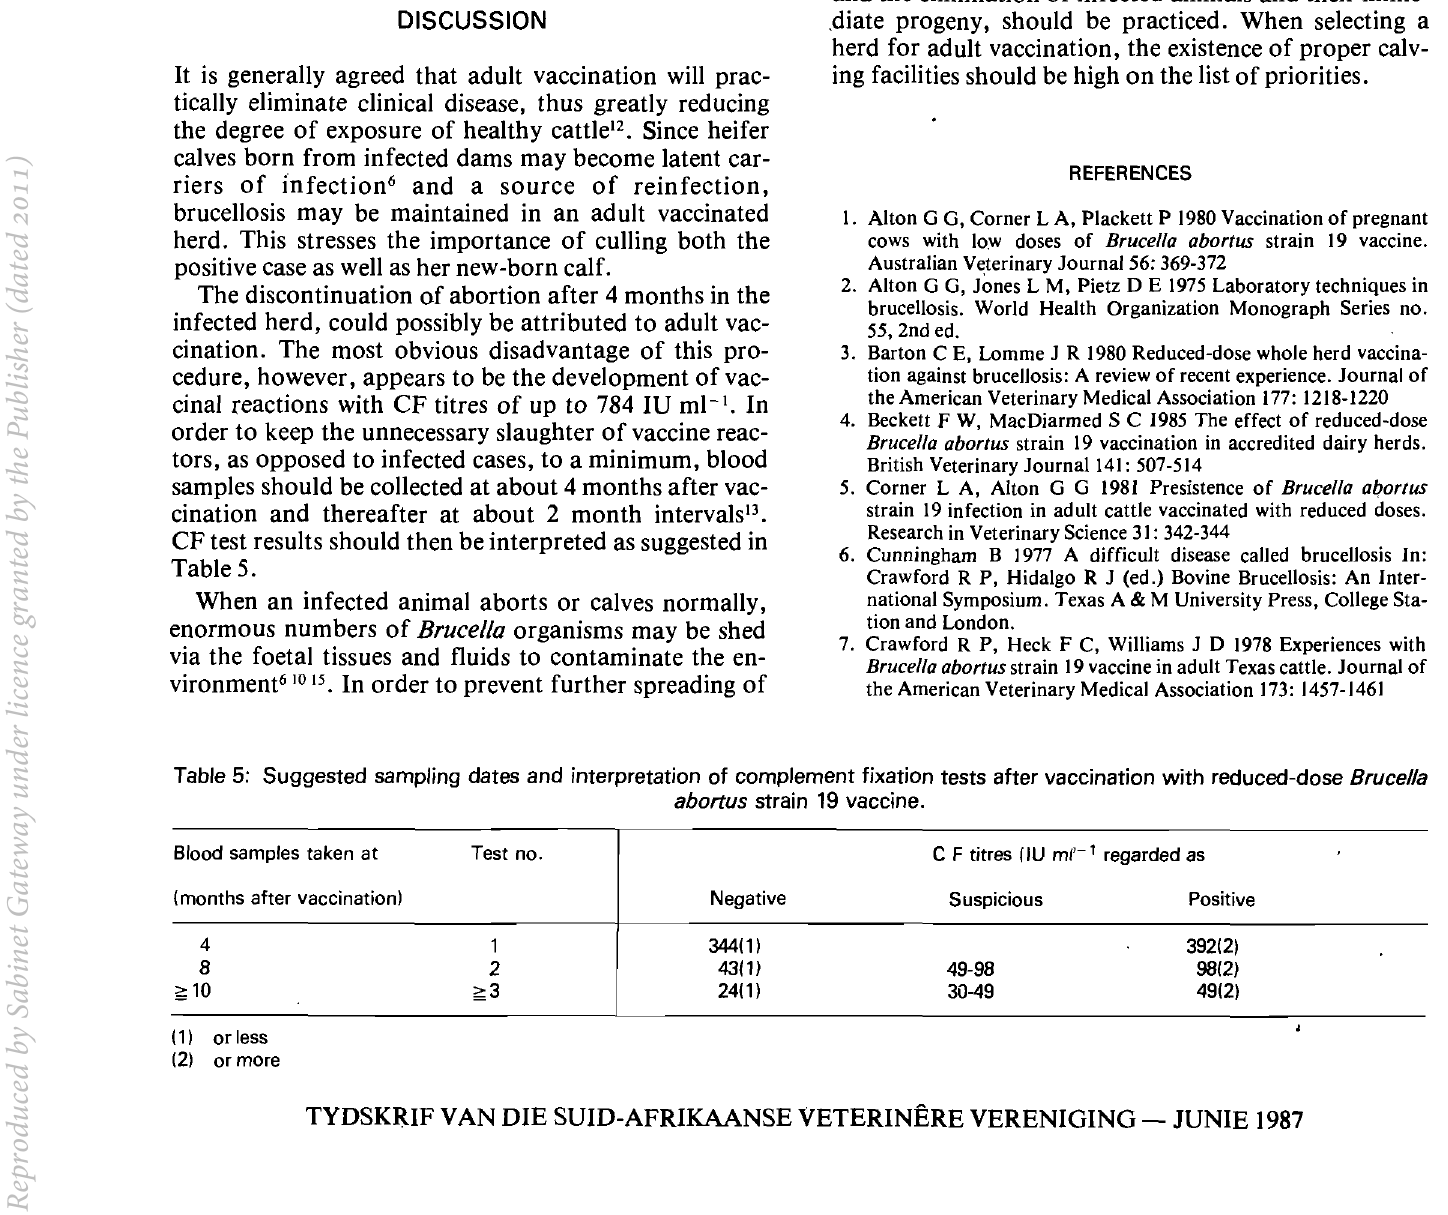
Table 5: Suggested sampling dates and interpretation of complement fixation tests after vaccination with reduced-dose Brucella Blood samples taken at (months after